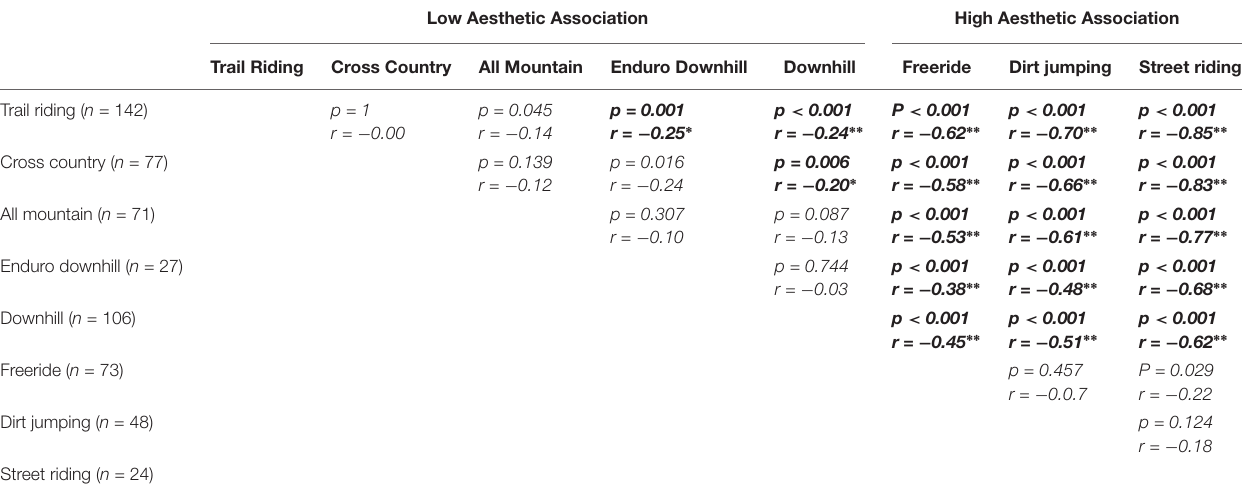
TABLE 5 | Comparative association of activity aesthetics between riding